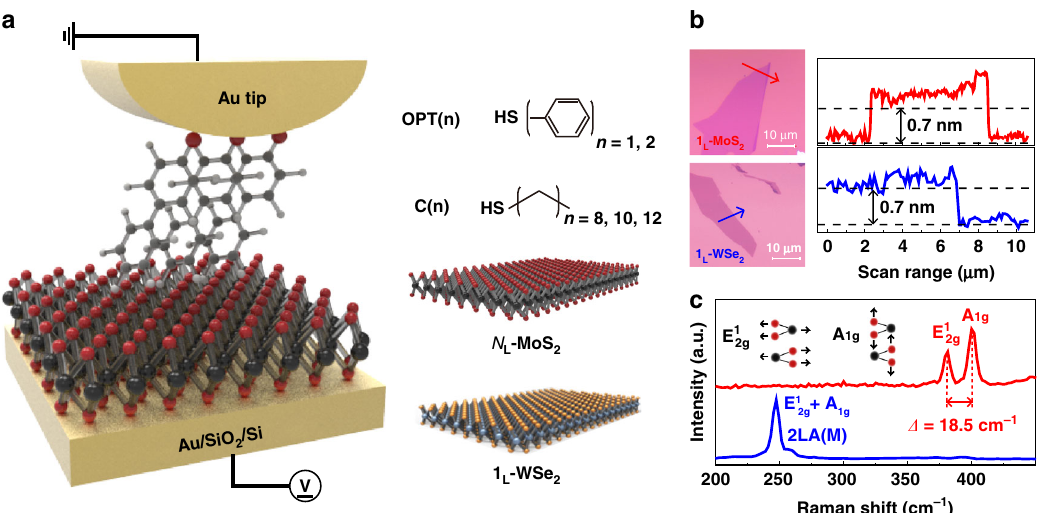
Fig. 1 Molecular heterojunction structure. a Schematic of molecular heterojunction composed of OPT2 and 1 L -MoS 2 stacked on an Au/SiO 2 /Si substrate using the CAFM technique (left). Note that the tip-loading force ( F L ) was fi xed at 1 nN to prevent variation in the interfacial coupling between the molecules and TMDs. Five different molecular species (OPT ( n = 1, 2) and C ( n = 8, 10, 12)) and two different 2D semiconductor types ( N L (1 L , 2 L , or 3 L )- MoS 2 , and 1 L -WSe 2 ) are shown (Right). b Topological line-pro fi les of 1 L -MoS 2 (red line) and 1 L -WSe 2 (blue line) on SiO 2 /Si substrate from AFM in non- contact scanning mode. Arrow in optical image of each TMD indicates the investigation range of the line-pro fi les. c Raman spectra of 1 L -MoS 2 (red line) and 1 L -WSe 2 (blue